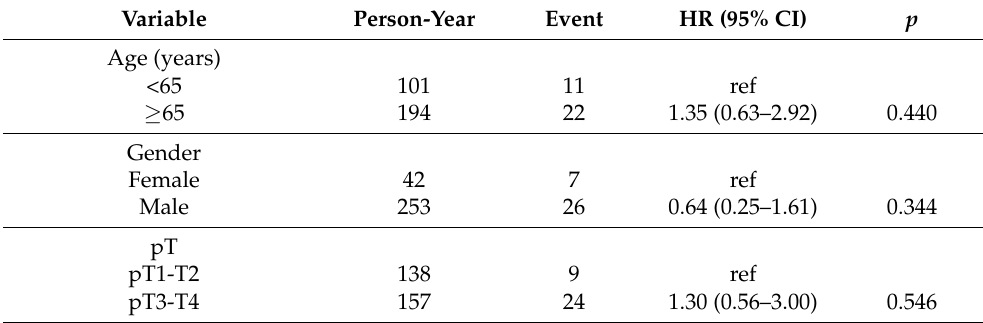
Table 3. Multivariable analysis of patients’ 5 year overall